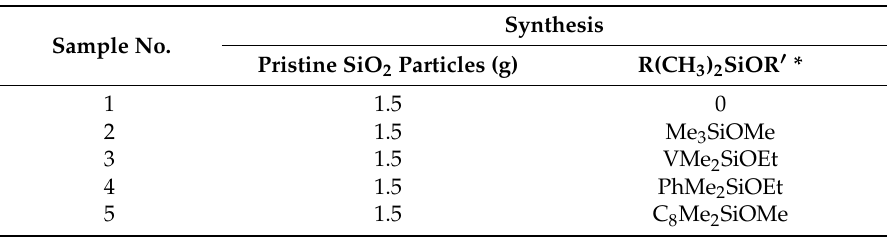
Table 2. Synthesis conditions for functionalization of silica.